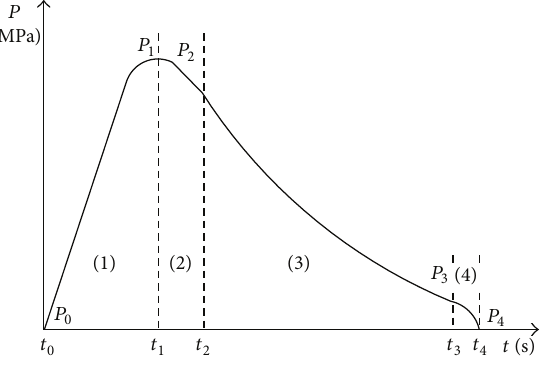
Figure 5: Blasting loading model.